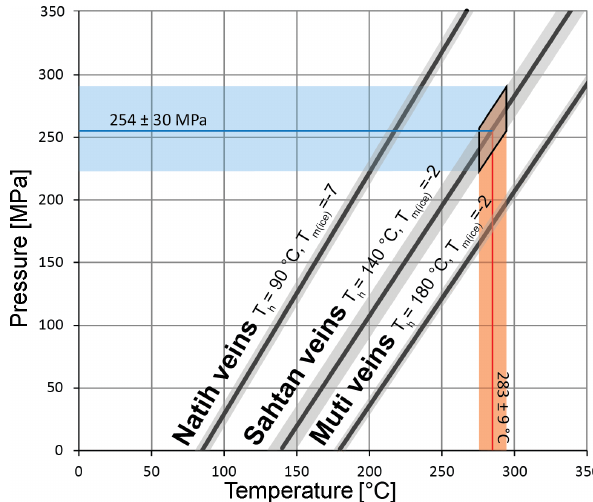
Figure 5. Fluid-inclusion isochores (solid black lines) of analyzed fluid-inclusion populations with corresponding standard deviations (shaded areas; for Sahtan Group data from Holland et al., 2009b, conservatively ± 10 ◦ C are assumed). To estimate the pressure con- ditions during vein formation, calculated temperatures from thermal maturity data are added for the Sahtan Group (red line with error) and result in minimum trapping pressures of 254 ± 30MPa during peak burial (blue line with